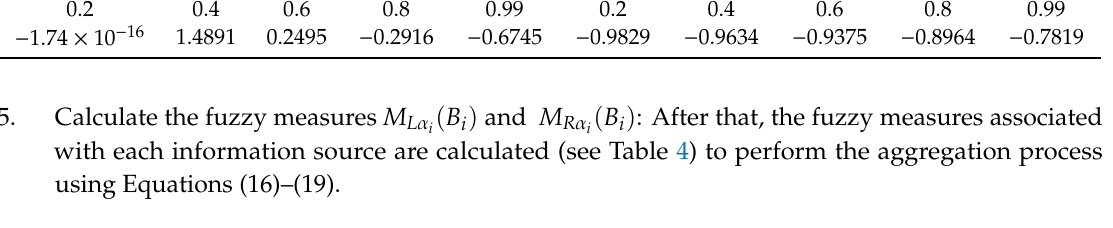
Table 4. Fuzzy measures calculated by each alpha cut.